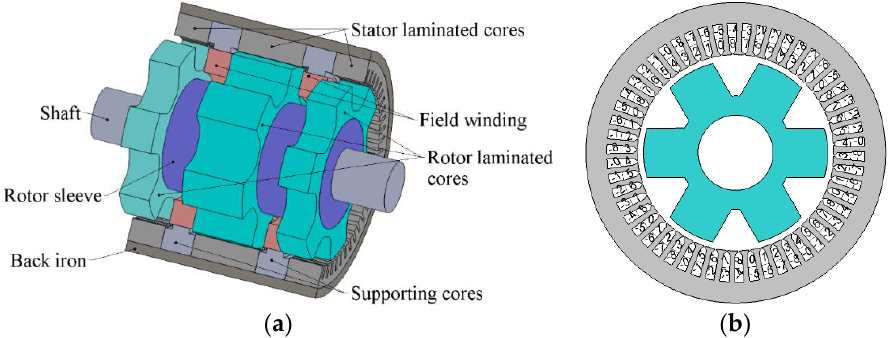
Figure 1. SHM design features: ( a ) general view of the SHM. The armature winding on the stator is not depicted so as not to obstruct; ( b ) SHM cross-section.